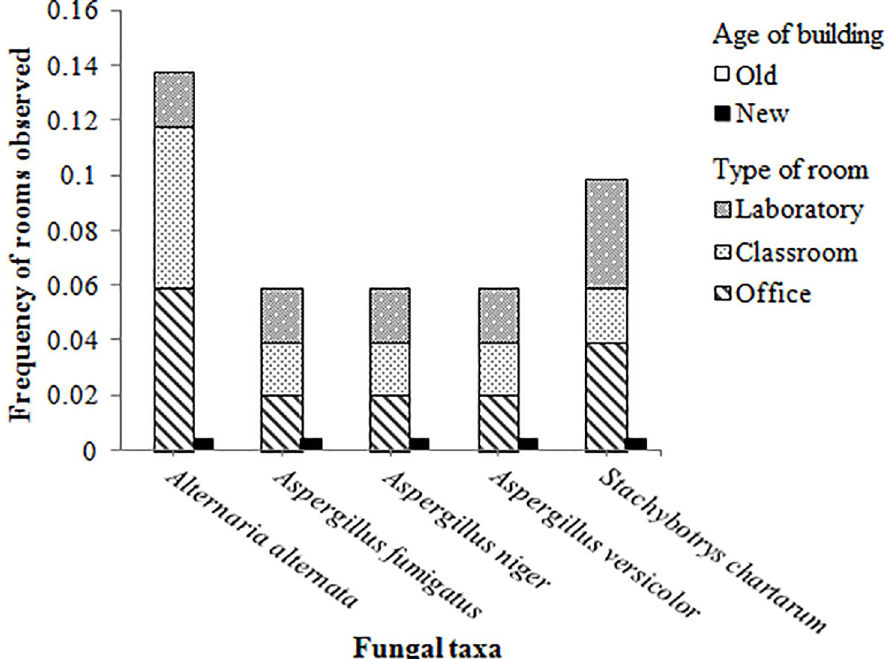
Fig 4. The fungal taxa present in rooms of the sampled buildings. No significant differences in fungal diversity were observed for the type of room and type of flooring. Significant differences in frequency of rooms were observed for each genus for the age of building, using chi-square test (p <